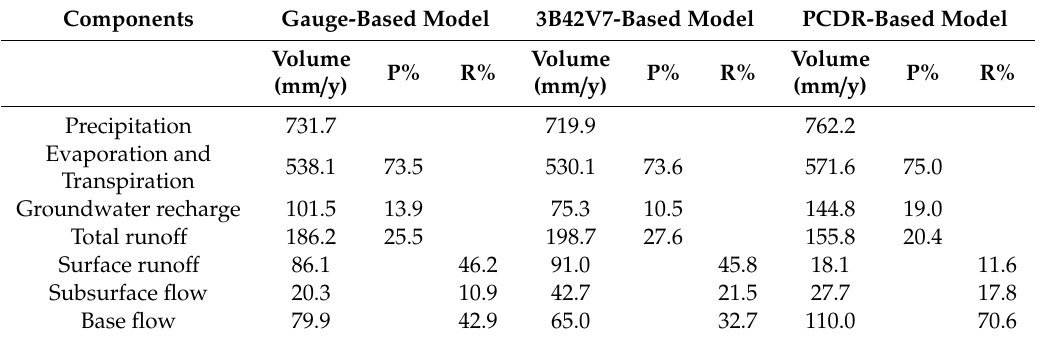
Table 6. Water balance components of the gauge-based, and 3B42V7- and PCDR-based